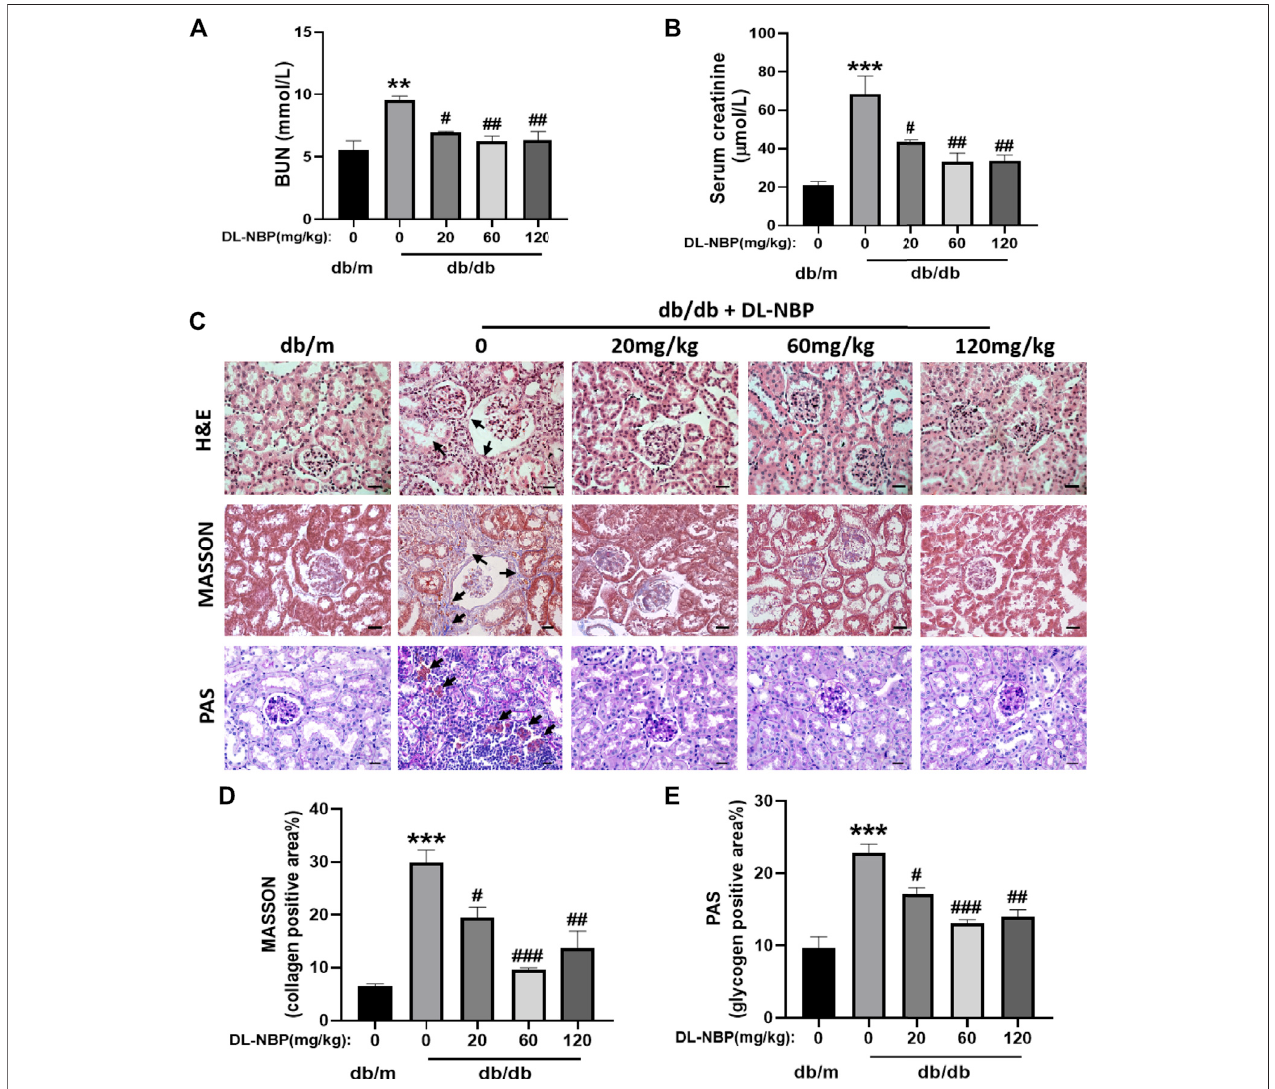
FIGURE 2 | DL-NBP treatment ameliorates renal injury in db/db mice. (A,B) BUN and Cr levels in serum from db/m mice, db/db mice, and DL-NBP treated mice (db/db mice were treated with 20, 60, or 120 mg · kg − 1 d − 1 of DL-NBP) ( n (cid:2) 8). (C – E) Representative images and quanti fi cation of H&E, Masson ’ s trichrome, and PAS staining (original magni fi cation × 400) in kidney of mice from each group ( n (cid:2) 3), Scale bar (cid:2) 20 μ m. Data are presented as the mean ± SEM; ** p < 0.01, *** p < 0.001 vs. db/m control mice; # p < 0.05, ## p < 0.01, ### p < 0.001 vs. db/db mice. BUN, blood urea nitrogen; Cr, creatinine; H&E, hematoxylin and eosin.